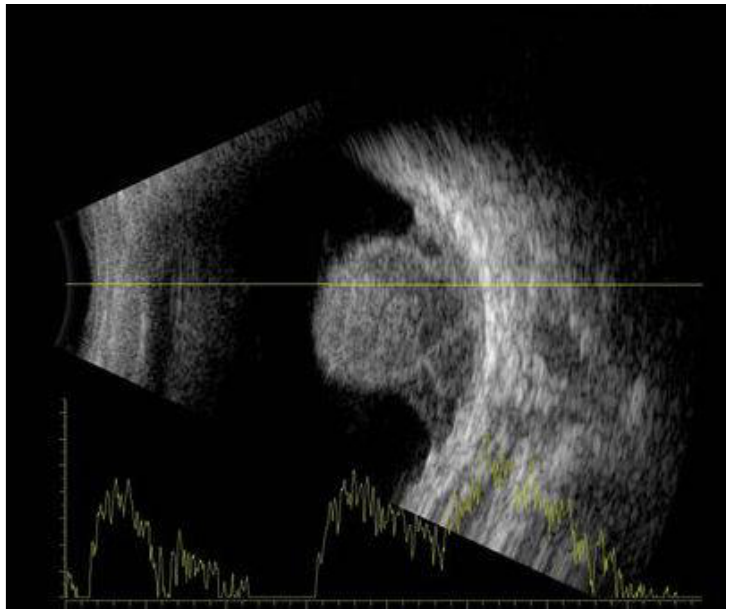
Figure 5. B-scan US shows a mushroom or dome-shaped tumour. The mass is acoustically silent, indicating a dark appearance inside the tumour.